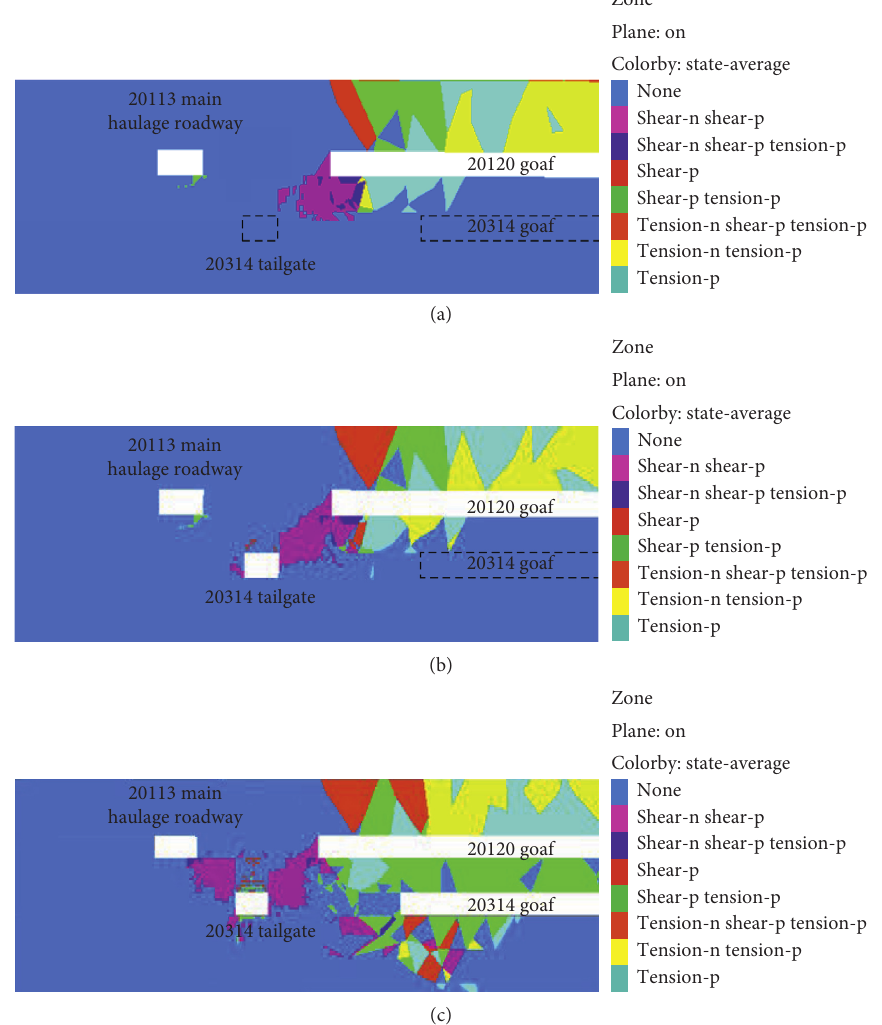
Figure 16: Nephogram of the plastic zone perpendicular to the section of the auxiliary haulage roadway (perpendicular to the axis section of the roadway): (a) 2-2 upper coal seam excavation; (b) 20314 tailgate excavation; (c) 20314 panel